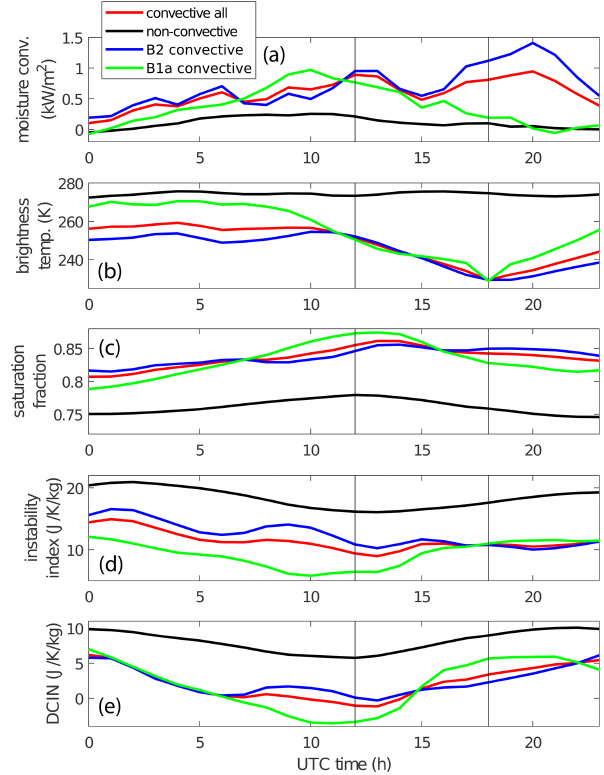
Figure 10. (a) Saturation fraction (SF): observations vs. YDPS. (b) Saturation fraction: YDPS vs. NDPS. (c) Instability index (II): observations vs. YDPS. (d) Instability index: YDPS vs. NDPS. (e) DCIN: observations vs. YDPS. (f) DCIN: YDPS vs. NDPS.